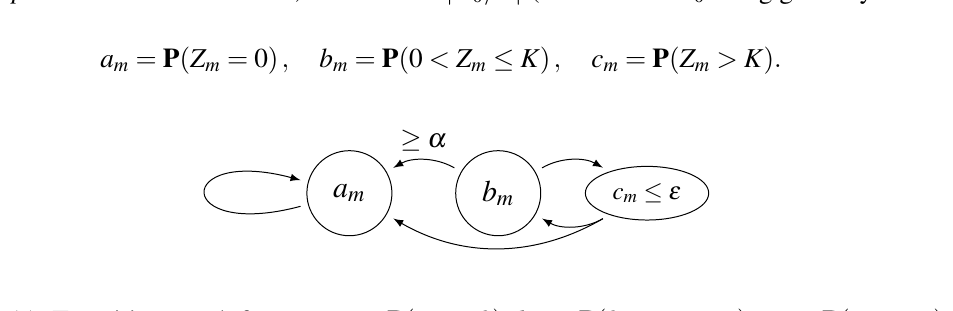
Figure 11: Transition graph for Z m : a m = P ( Z m = 0 ) , b m = P ( 0 < Z m ≤ K ) , c m = P ( Z m > K )